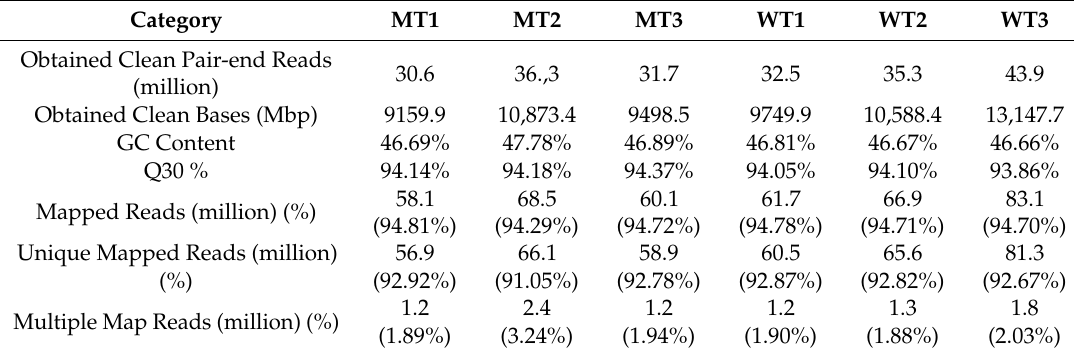
Table 2. Summary for the transcriptome of MT and WT